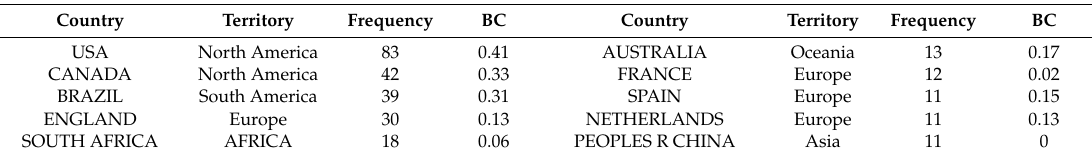
Figure 3. International collaboration network. According to Table 1, America accounts for 60.74% of the total output in the top ten countries, Europe for 24.44%. Moreover, in the light of the higher BC of the USA (0.41), Canada (0.33), and Brazil